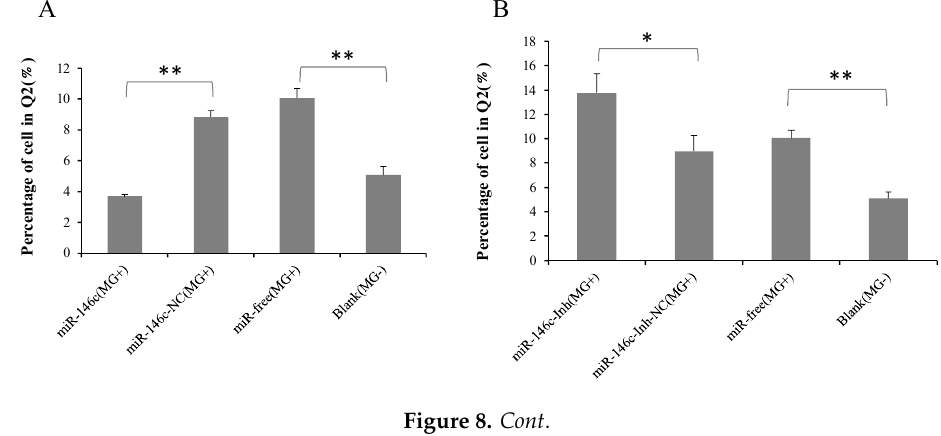
Figure 7. Cycle procession of DF-1 cells was affected by gga-miR-146c. Four groups of transfection treatments were carried out. Values are mean ± SD, * p < 0.05, ** p < 0.01. ( A , C ) Cell cycle was dramatically promoted with gga-miR-146c overexpression; ( B , C ) Cell cycle was suppressed by gga-miR-146c inhibitor.